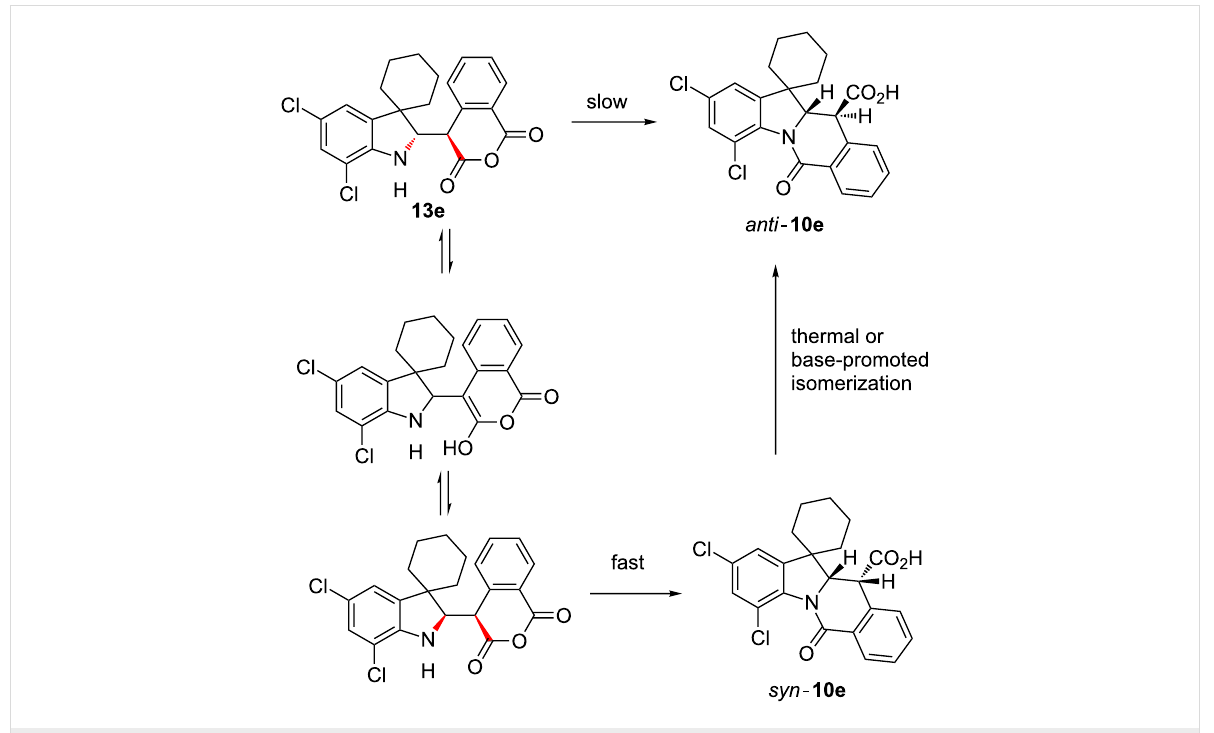
Scheme 5: Mechanistic rationale for the 13e → syn/anti - 10e